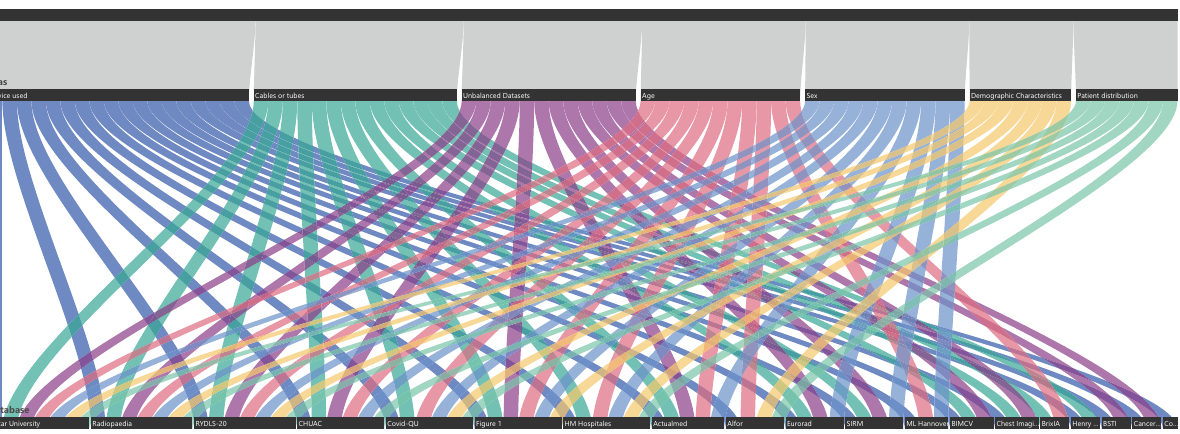
Figure 7. Bias for each COVID-19